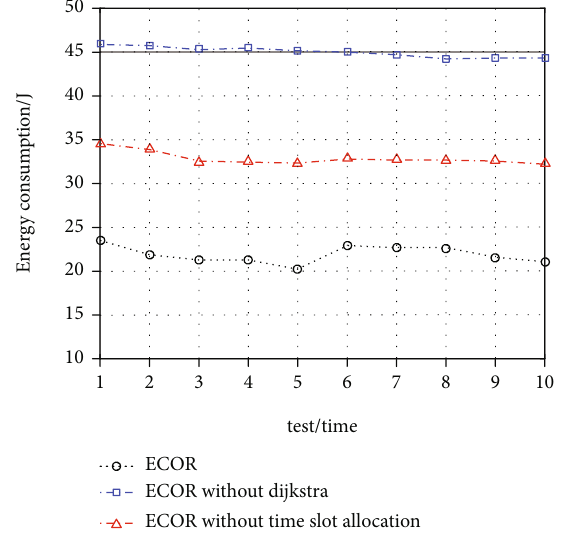
Figure 14: Consumed Energy of ECOR, ECOR without Dijkstra, and ECOR without time slot